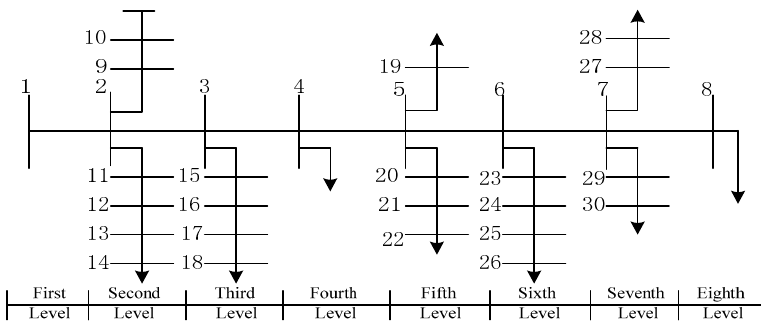
Figure 3. The hierarchical division diagram of the AC/DC hybrid DN.